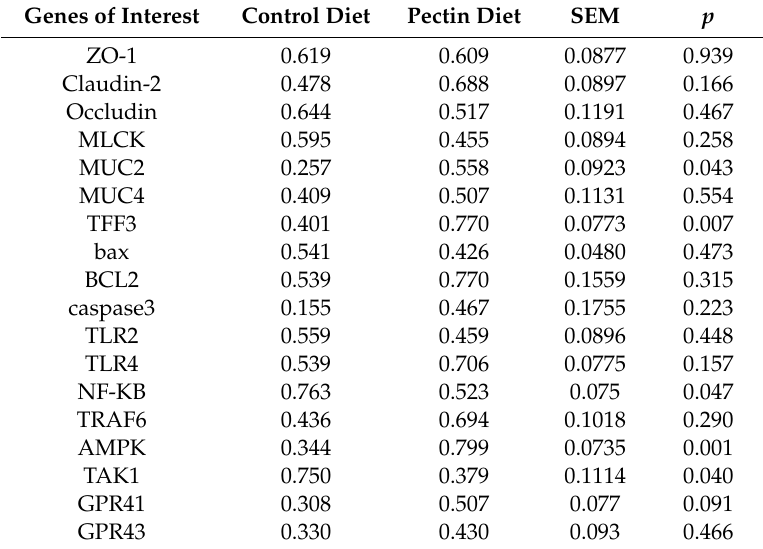
Table 2. Relative expression of genes related to luminal defense, barrier function, apoptosis and the innate immune signaling cascade in the cecum of pigs fed either the control (CON) or pectin (PEC) diet. (Mean values with their standard errors; n = 6 /